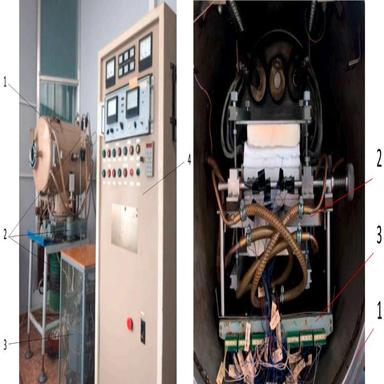
Experimental set-up for heat transport properties analysis. On the left, a general view of TVS-2M stand: 1 - vacuum chamber, 2 - vacuum system, 3 - power system, 4 -monitoring and control rack. On the right, inside of the vacuum chamber of TVS-2M stand: 1 - vacuum chamber, 2 - experimental module EM-3D, 3 connector blocks of thermocouples.